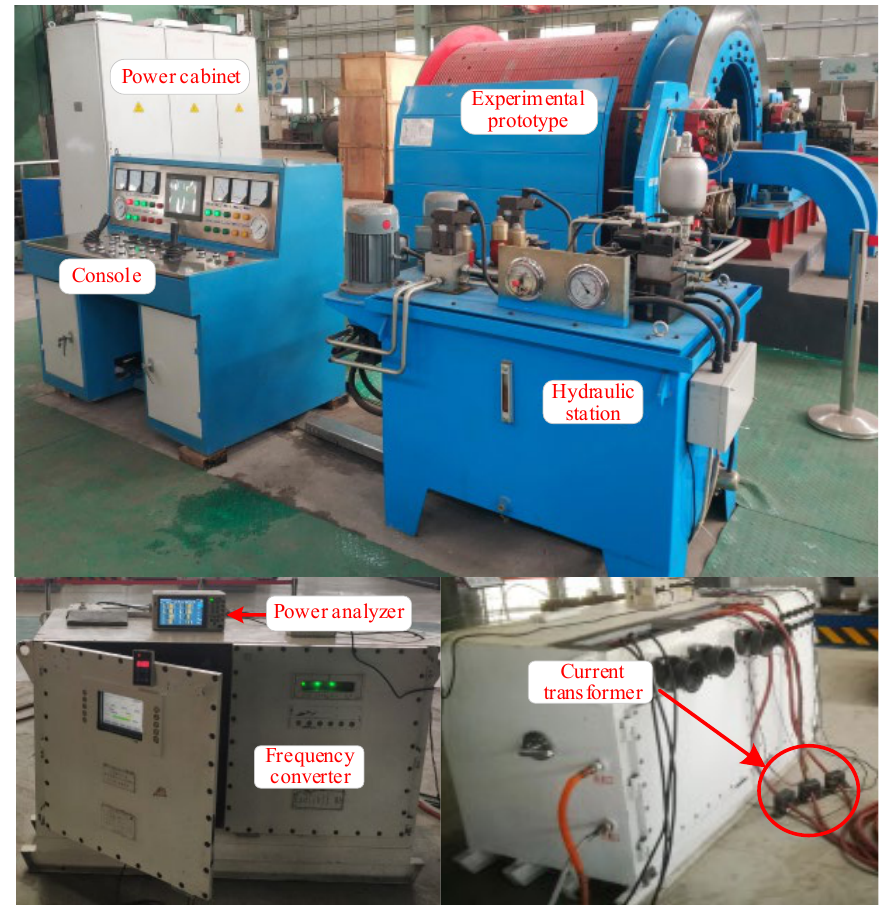
Figure 13. The testing platform of the LHPMSM prototype. As seen from Figure 14, the external surface of the drum is not wrapped with steel wire rope, and its normal operation can be equivalent to the no-load working condition. The experimental prototype rated parameters are set by the three-level frequency converter, as given in Table 2.